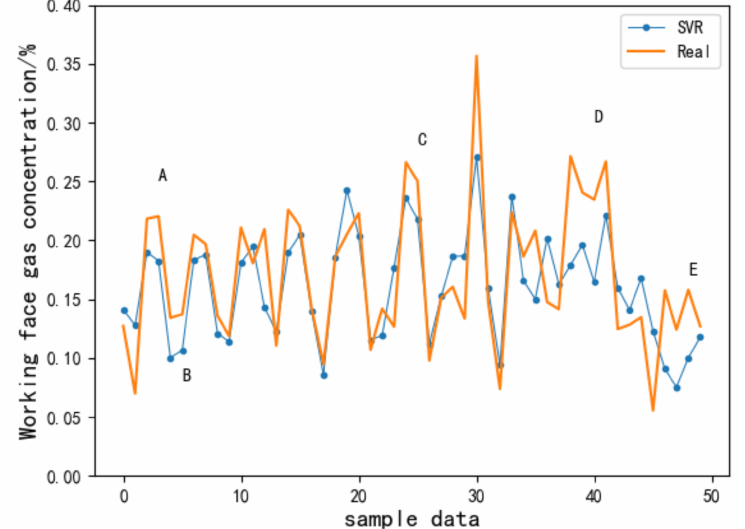
Figure 9. Prediction fitting based on